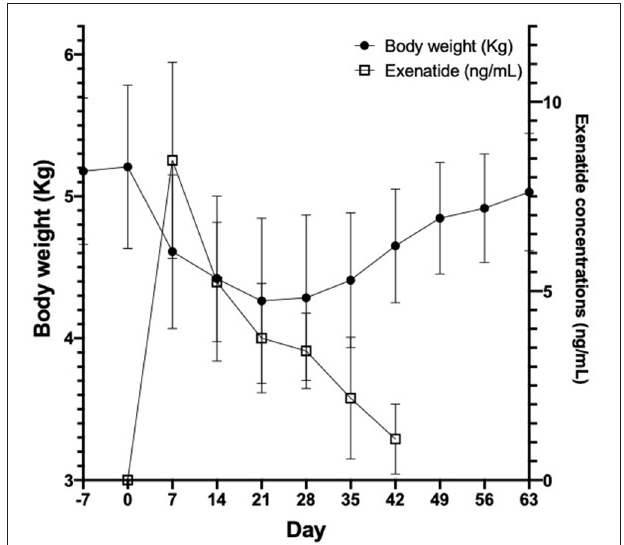
FIGURE 4 | Body weight (left axis, black circles) and exenatide plasma concentrations (right axis, open squares) in 4 healthy purpose-bred cats over 9 weeks, before and after insertion of OKV-119 configured with supratherapeutic levels of exenatide. Shown are mean ( ±